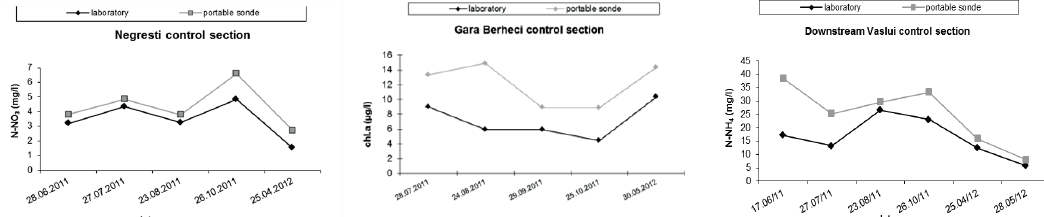
Fig. 5 Comparison between laboratory analysis and portable sonde measurements in different control sections along the Barlad main axis, for N-NO 3, chlorophyll a and N-NH 4